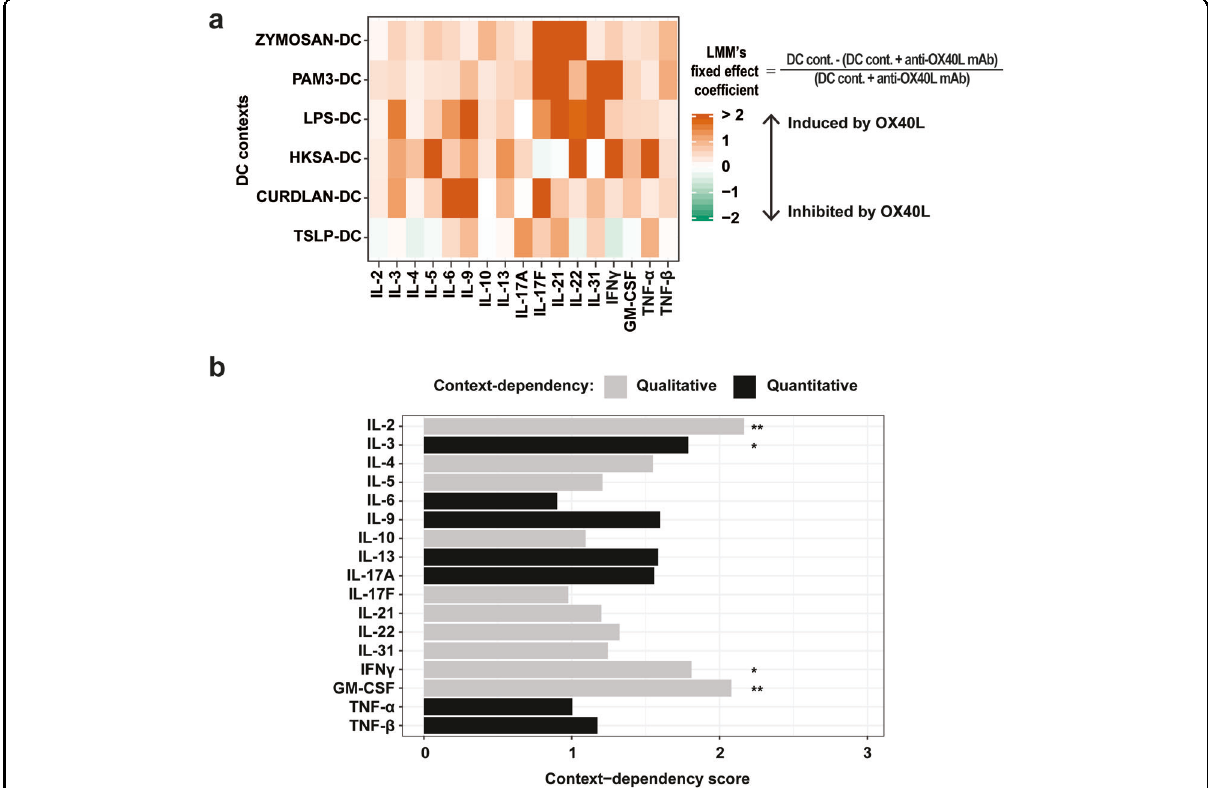
Fig. 4 TSLP-cDC2 context determines a speci fi c OX40L functional impact on Th output cytokines. a Heatmap representing the estimated OX40L-induced relative difference on the 17 output Th-cytokines measured in each cDC2 context, calculated using Linear Mixed-effects Models. The estimated coef fi cients for the fi xed effects from the models are represented. For a given cytokine, in a given cDC2 context, the LMM ’ s coef fi cient corresponds to the mean over donors of the concentration in the presence of the isotype (DC cont.) subtracted by the concentration in the presence of anti-OX40L antibody (DC cont. + anti-OX40L mAb), divided by the concentration in the presence of anti-OX40L antibody (DC cont. + anti-OX40L mAb). b Scoring of the context-dependency across the six cDC2 contexts, ranked according to statistical signi fi cance. Black bars represent a quantitative OX40L context-dependency, meaning the variation of a considered output cytokine in one direction (increase or decrease) in all the cDC2 contexts in the presence of OX40L. Grey bars indicate a qualitative OX40L context-dependency, meaning variation of an output cytokine in the opposite direction in at least one cDC2 context due to the presence of OX40L. Likelihood ratio tests, between the LMM with and without the context variable as a fi xed effect, were used to assess the signi fi cance of the context-dependency. * P ≤ 0.05; ** P ≤ 0.01; *** P ≤